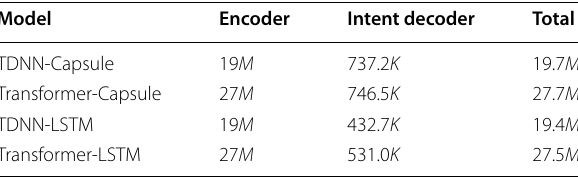
Table 6 Number of parameters in the SLU